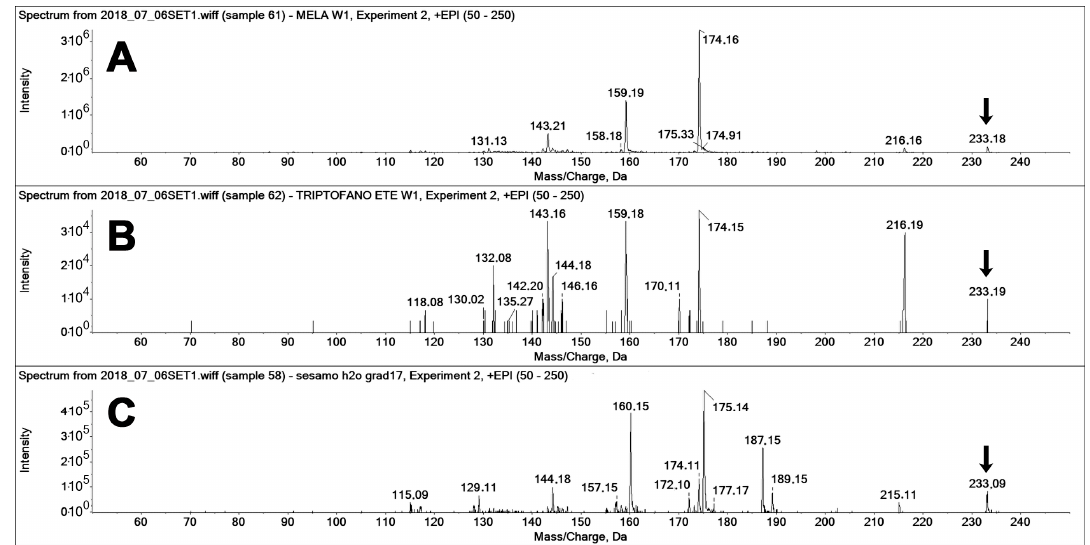
Figure 7. MS/MS spectra of different compounds with 233 m / z acquired on-the-fly in enhanced product ion (EPI) mode (at 20 eV collision energy). ( A ) Spectra of authentic MEL (standard solution, 20 ng injected), ( B ) Spectra of authentic TEE (standard solution, 20 ng injected), and ( C ) Spectra of MEL isomers in the sesame extracts (peak 2 in Figure 6). The latter presented a main 187 m / z , which is not appreciable on the spectra of the two standards.